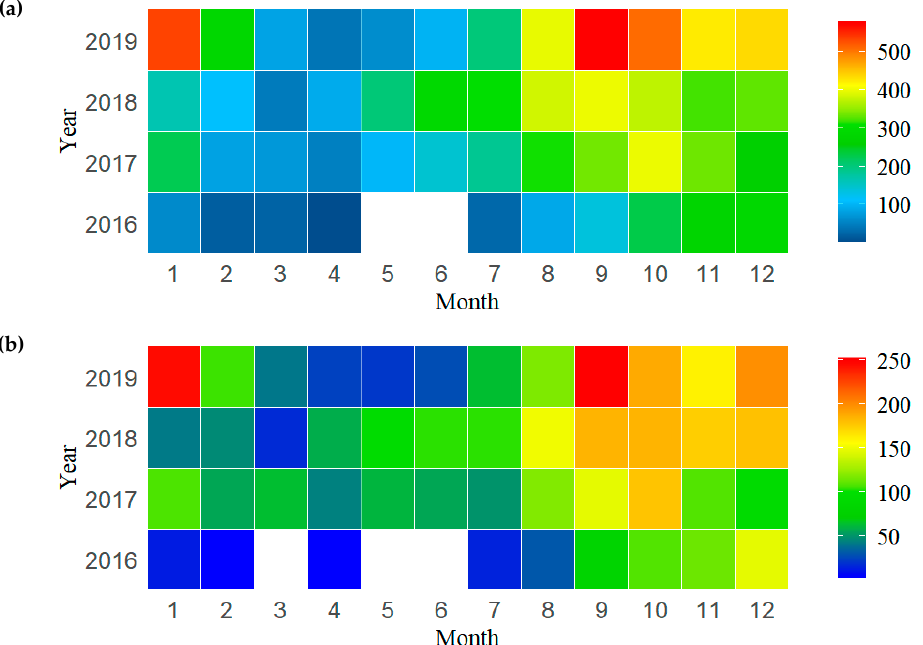
Figure 2. ( a ) Monthly distribution of the observed number of fishing sets in Chinese tuna longline fisheries. ( b ) Monthly distribution of the observed number of fishing sets with the presence of P. violacea .